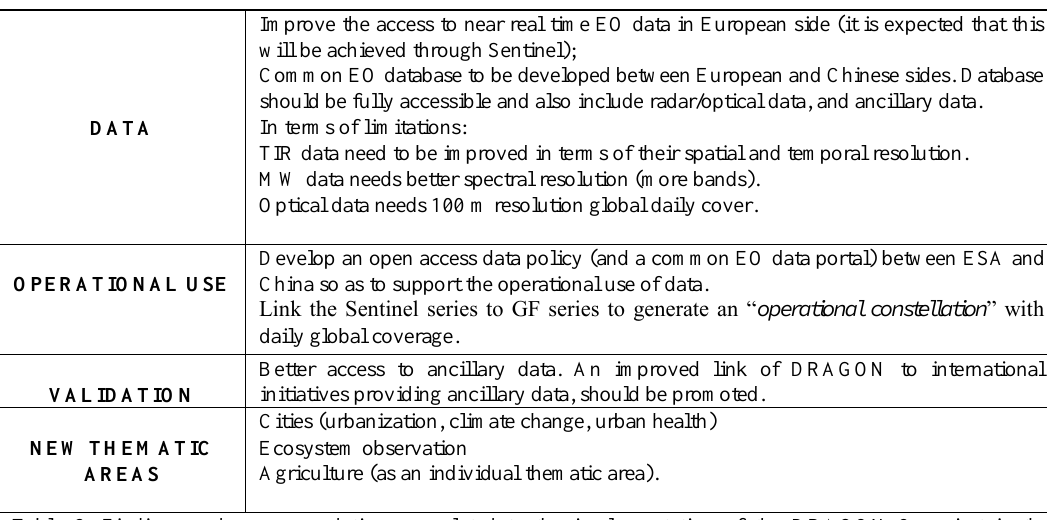
Table 2. Findings and recommendations as related to the implementation of the DRAGON 3 project in the thematic domain “Land and